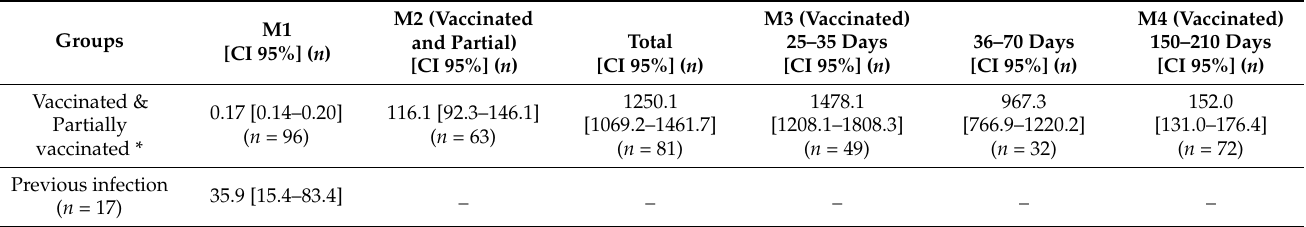
Table 2. Geometric Mean (GM) of SARS-CoV-2 IgG (anti-RBD/S) concentration titers at four different moments for the full-vaccinated, partially vaccinated participants and at moment of recruitment for individuals with previous